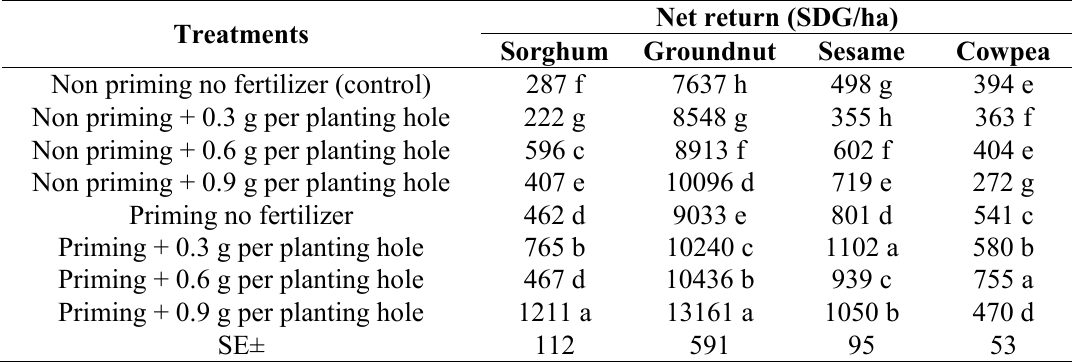
Table 11. Economic analysis of the different seed priming and micro-dosing treatments.